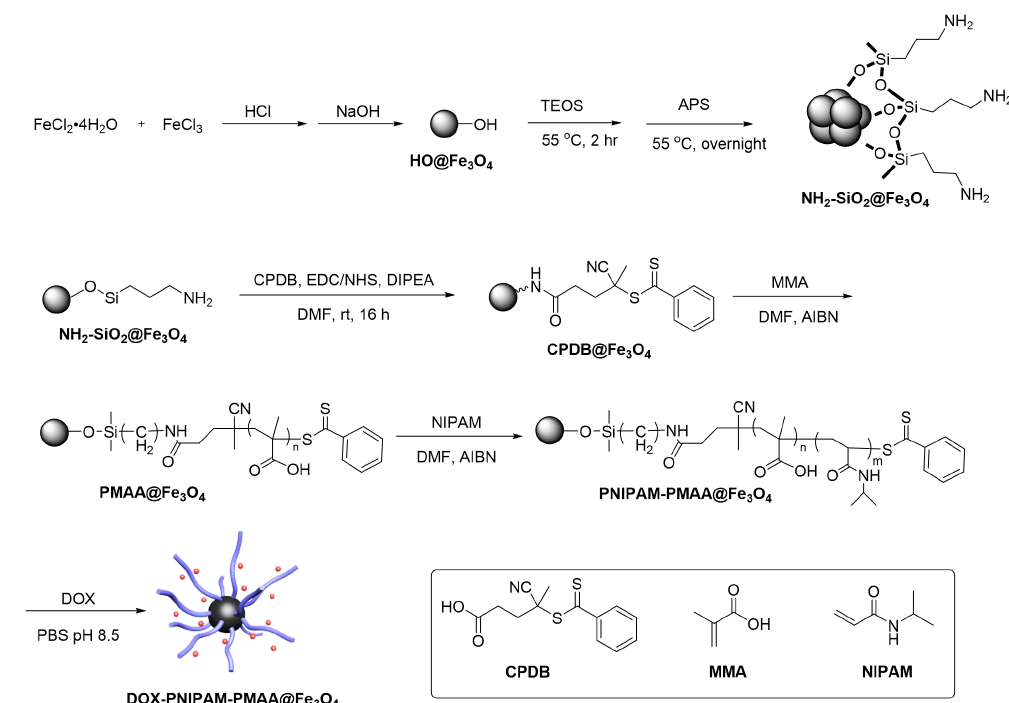
( b ) Figure 2. Distribution pattern of the hydrodynamic diameters of ( a ) HO@Fe 3 O 4, NH 2 -SiO 2 @Fe 3 O 4 and PNIPAM-PMAA @Fe 3 O 4 in dd-H 2 O and ( b )CPDB@Fe 3 O 4, andPMAA@Fe 3 O 4 in dimethyl formaldehyde (DMF). Table 1. The analysis of dynamic light scattering (DLS) for particles. Size (nm)